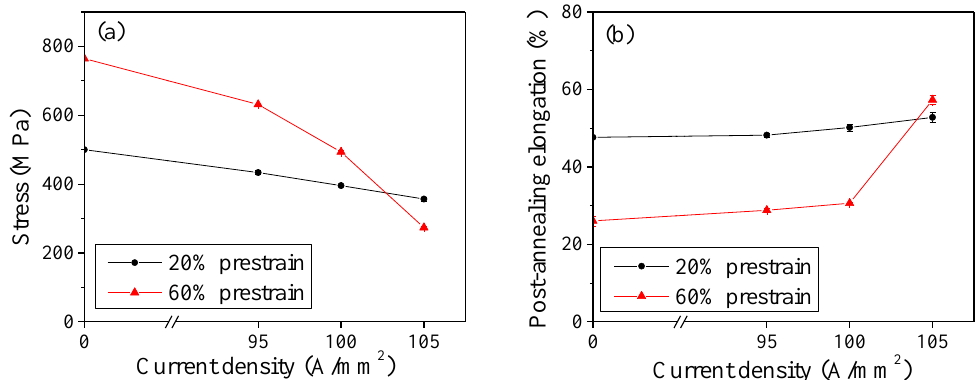
Figure 5. ( a ) Post-annealing yield strength and ( b ) post-annealing elongation of prestrained specimens after EA annealing.